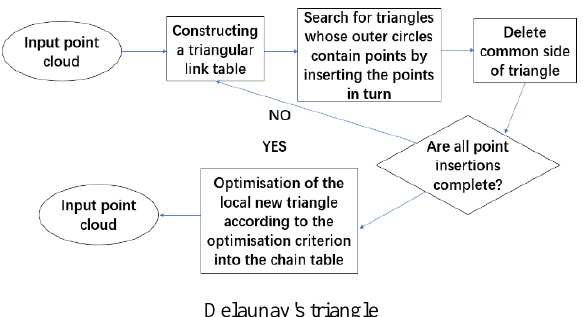
Delaunay's triangle